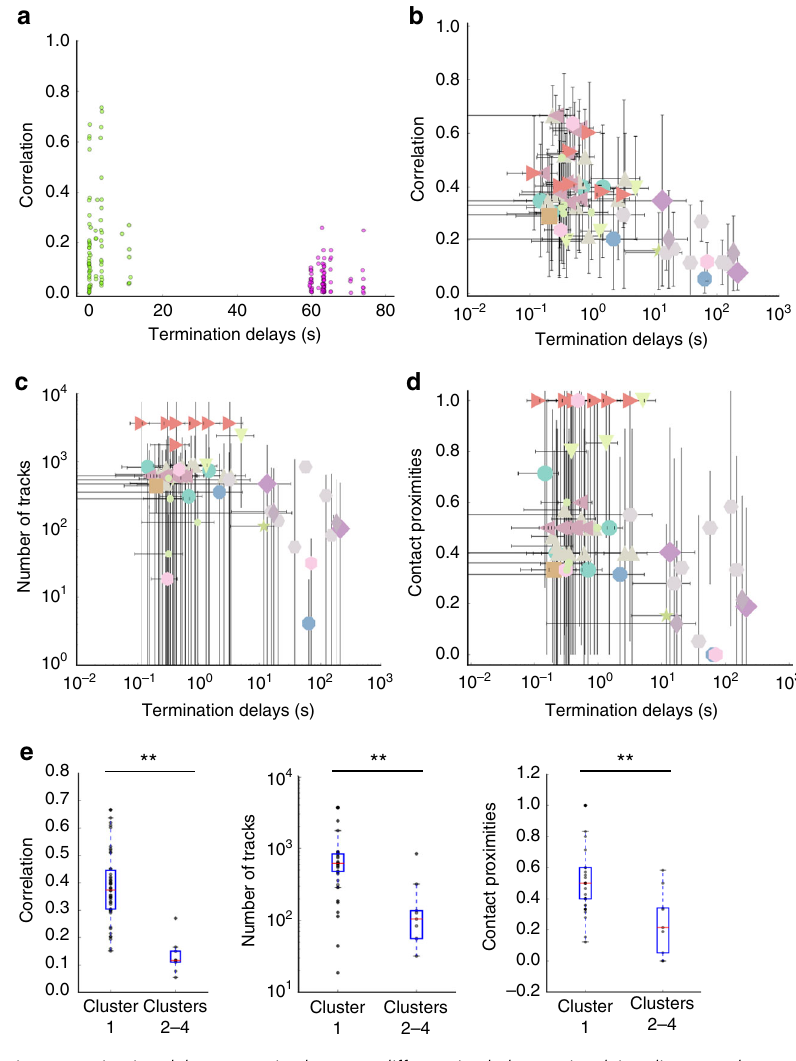
Fig. 7 Large differences in seizure termination delays can arise between different ictal clusters involving distant and not well connected brain regions. a Pairwise correlations as a function of the pairwise termination delays for stereotactic contacts from an example seizure (Fig. 1). Green and violet dots identify clusters based on the pairwise termination delays. b Mean pairwise correlation between contacts as a function of the corresponding pairwise termination delays for all contacts, patients and seizures. Each point corresponds to the mean for each one of the clusters obtained as in a . Each color/ symbol indicates a different patient. The vertical and horizontal bars indicate the standard deviation in the corresponding coordinate. Note the log scale in the x -axis. c Mean pairwise number of tracks between contacts as a function of corresponding pairwise termination delays. Same conventions as in b . Note the log scale in both the x - and y -axes. d Mean pairwise contact proximities as a function of corresponding pairwise termination delays. A value of one indicates that all pairwise contacts in the cluster are in contiguous brain regions. Same conventions as in b . e Whisker plots for pairwise correlation, number of tracks, and contact proximities for cluster one (smallest termination delays) vs. the other clusters (longer termination delays) across patients. Statistically signi fi cant differences are indicated (** P < 0.01; Mann – Whitney U-test, n =